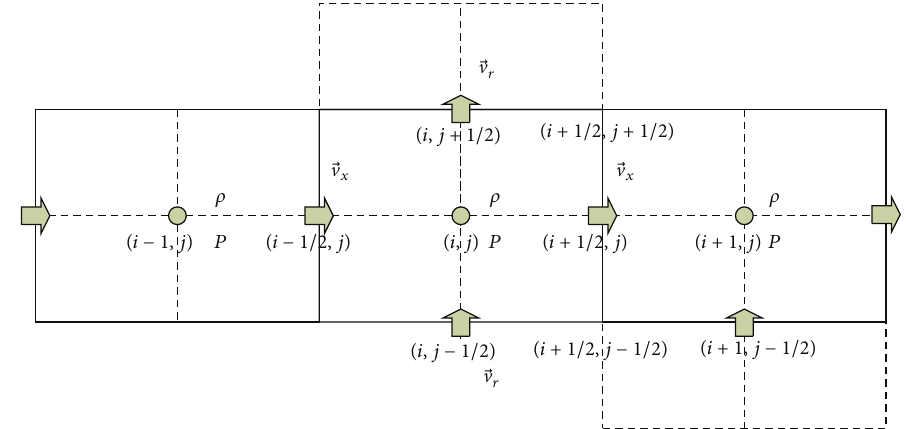
Figure 3: The staggered grid system.